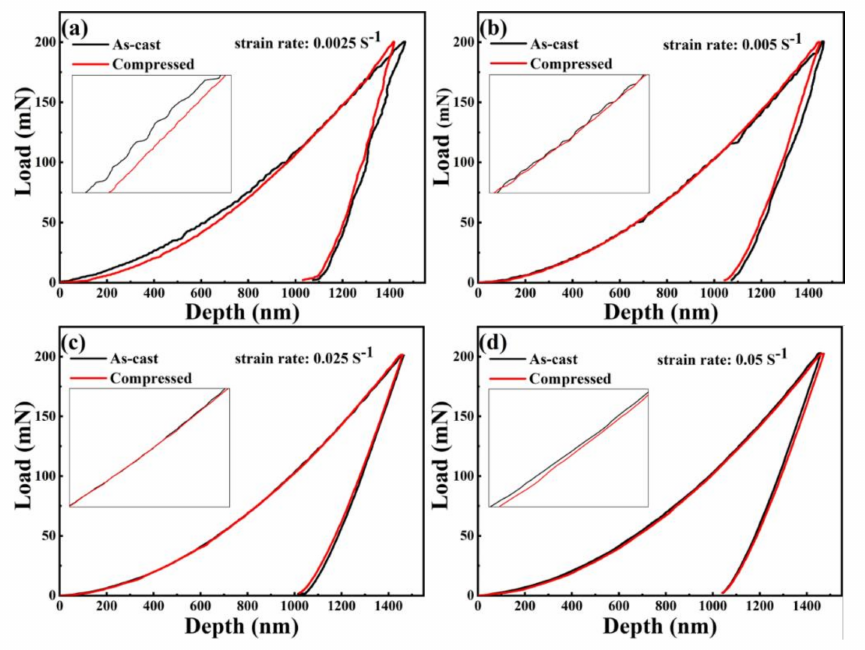
Figure 1. Load-penetration curves of as-cast versus compressed BMGs at equivalent strain rates ( a ) 0.0025 s − 1 , ( b ) 0.005 s − 1 , ( c ) 0.025 s − 1 , and ( d ) 0.05 s − 1